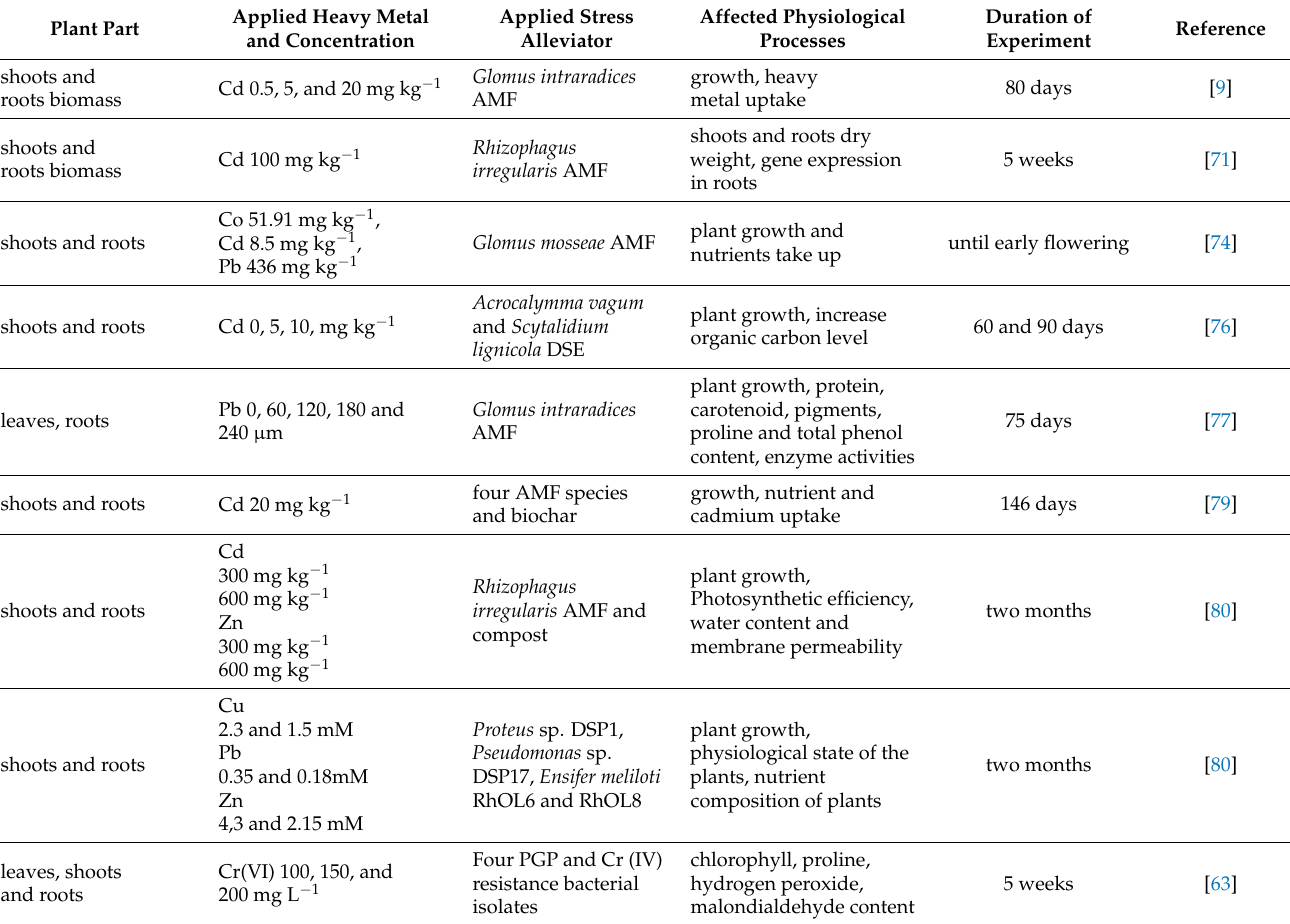
Table 2. Plant part, applied fungi and/or bacteria, affected physiological processes and the duration of treatment of HM-treated alfalfa